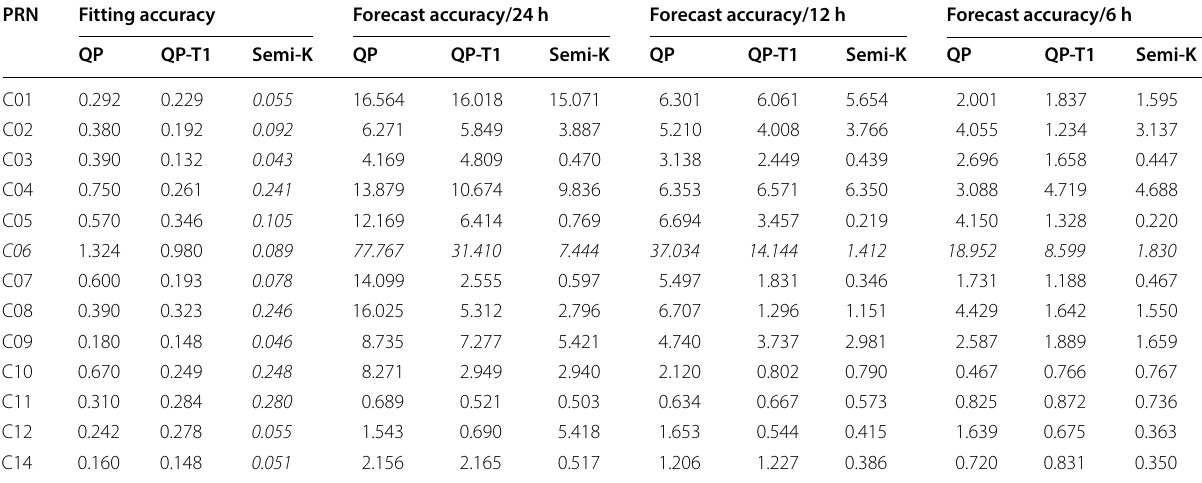
QP represents the basic prediction model; QP-T1 represents the periodic term model after adding the correction of the first main period term; Semi-K represents the semiparametric adjustment model considering model errors